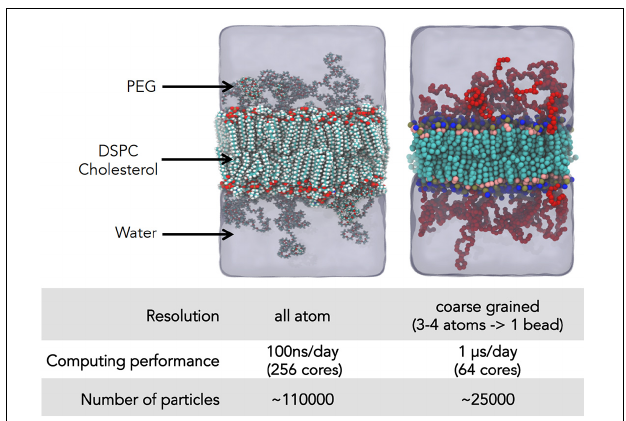
FIGURE 2 | Illustration of coarse graining: the same system, a PEGylated membrane, modeled with an all atom and a MARTINI model is shown along with the decrease in number of particles and acceleration in the simulation time. Figure taken from Bunker: (Bunker et al., 2016) with